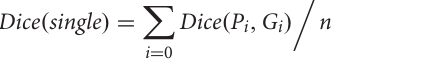
Frontiers in Physiology |